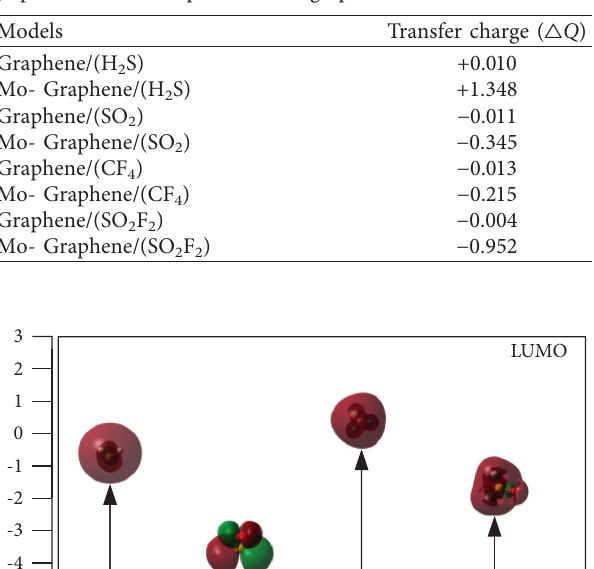
Table 4: Transfer charge of gas molecules on the surface of intrinsic graphene and Mo-doped intrinsic graphene.